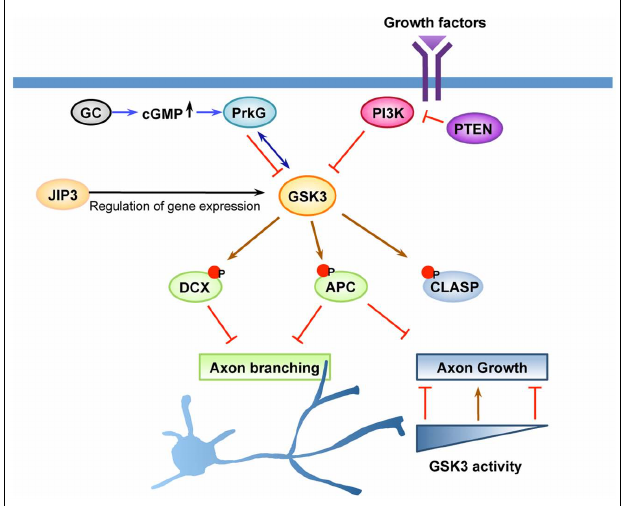
FIGURE 2 | GSK3 is a key regulator of axon growth and branching. Axon growth is thought to be initiated by activation of cell surface receptors upon recognition of extrinsic cues, such as growth factors or other ligands. GSK3 has been suggested as a key molecule downstream of the PI3K pathway and the cyclic guanosine monophosphate (cGMP) pathway to control axon growth and/or branching. Upon activation of PI3K, GSK3 becomes inactivated, leading to dephosphorylation of GSK3 substrates that control the stability and dynamics of axonal microtubules. Dephosphorylation and subsequent binding of adenomatous polyposis coli (APC) on microtubule plus ends at certain locations along the axon enhances axonal branching, whereas its enrichment at the growth cone leads to the promotion of axon growth. CLASP, another substrate of GSK3 that binds to microtubules in response to GSK3 inactivation, plays a role to regulate axon growth downstream of GSK3. CLASP can both promote and inhibit axon growth depending on its microtubule-binding activity, a property which is tightly controlled by GSK3 activity.The cGMP pathway is another pathway that has been shown to control axonal branching. In response to elevation of cGMP by activation of guanylyl cyclase (GC), cGMP-dependent protein kinase G (PrkG) becomes activated and functions to increase axon branching by inactivating its substrate GSK3. In addition to the direct regulation of the kinase activity, GSK3 activity can be controlled by other mechanisms, such as regulation of its expression level. JNK-interacting protein (JIP) 3 has been suggested to control the expression level of GSK3 at the transcription level and/or by regulating mRNA stability. Down-regulation of JIP3, which decreases GSK3 level, increases axonal branching by controlling the phosphorylation status of doublecortin (DCX), a substrate of GSK3. Coordinated regulation of multiple GSK3 substrates likely defines the extent of axon growth and the locations at which axonal branching